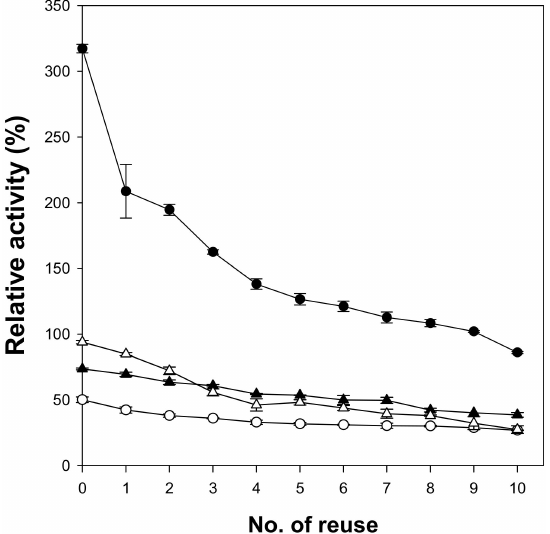
Figure 5. Relative activity of lipases immobilized on the magnetic cellulose microspheres after reuse. ( • ) Cell-IL, ( ) Cell-NaTU, ( (cid:78) ) Cell-TBAH, and ( (cid:52) ) (cid:35)